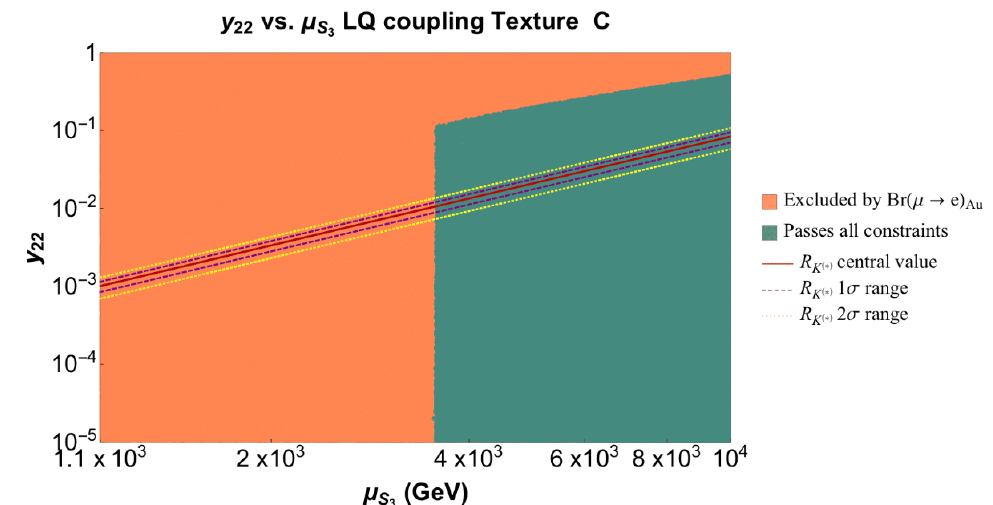
Figure 19 . Indicative plot of the allowed parameter space (in teal) in the y 22 vs. (cid:22) S leptoquark coupling matrix Texture C. The red line indicates the central value needed to explain the R anomalies with the purple (yellow) lines indicating the 1(2) (cid:27) bounds. Parameter space K ( (cid:3) ) exluded by Br( (cid:22) ! e ) is indicated in orange.